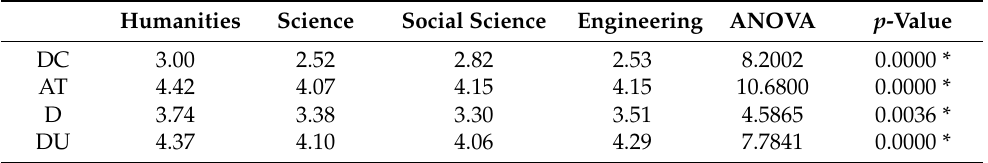
Table 8. Mean answers (out of 5) and ANOVA test statistics when differentiating participants by area of knowledge.